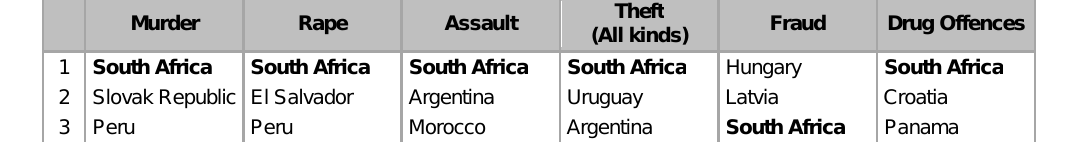
Countries with highest crime ratios: 2002 (High income countries